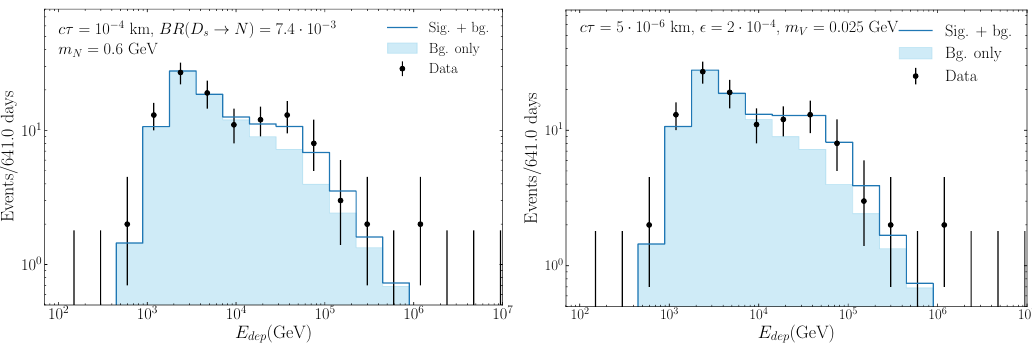
Figure 13 . Expected number of decays for the IC Medium Energy Starting Events (MESE) sample, as a function of the deposited energy in the detector and for the down-going sample only (cos (cid:18) > 0), for two of the scenarios considered in this work. The shaded histograms show the background prediction, including a (cid:12)tted distribution to the astrophysical neutrino signal, the cosmic muon background, and atmospheric neutrino events. The black dots correspond to the observed data with error bars, as in ref. [39]. In the left panel, the signal has been computed for a HNL with a mass m N = 0 : 6 GeV, a c(cid:28) N = 10 (cid:0) 4 km and Br( D s ! N ) Br( N ! CC e-like) = 7 : 4 (cid:1) 10 (cid:0) 3 . In the right panel, the signal has been computed for a dark photon with a mass m V = 25 MeV for (cid:15) = 2 (cid:1) 10 (cid:0) 4 and an (uncorrelated) lifetime c(cid:28) V = 5 (cid:1) 10 (cid:0) 6